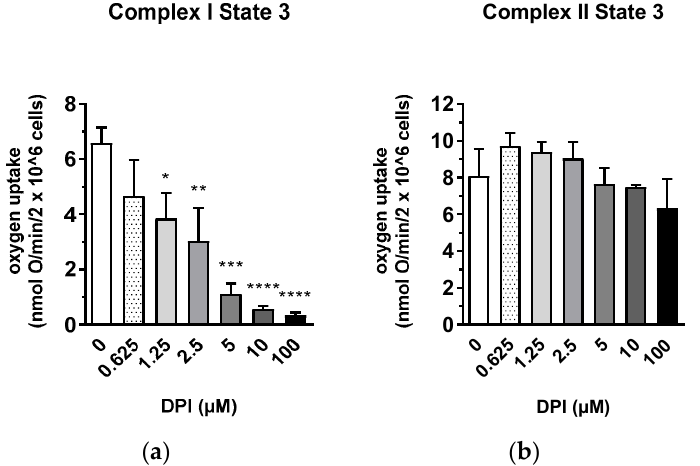
Figure 1. Inhibitory effect of diphenyleneiodonium chloride (DPI) on Complex I mitochondrial function in permeabilized MG-63 cells. ( a ) Effects of different concentrations of DPI on Complex I-linked State 3. * p < 0.05, ** p < 0.01, *** p < 0.001, and **** p < 0.0001 compared to the control. ( b ) Effects of different concentrations of DPI on Complex II-linked State 3. Data is represented as means + SD (error bars) ( n = 3). One-way ANOVA followed by multiple comparison post-hoc Fisher’s LSD test.